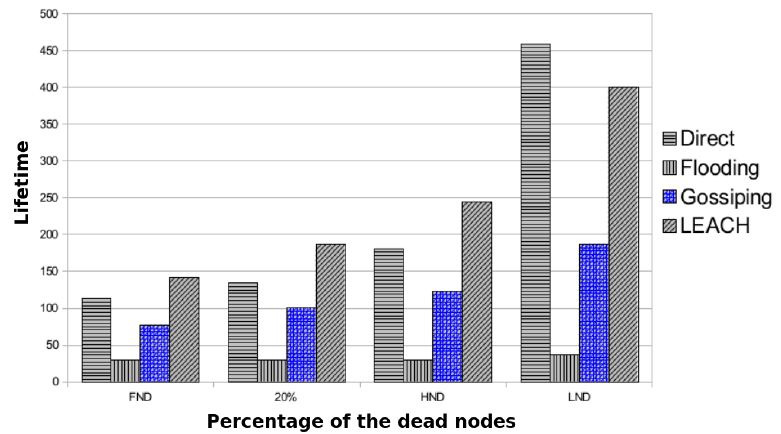
Figure 16. Power consumption of the network.